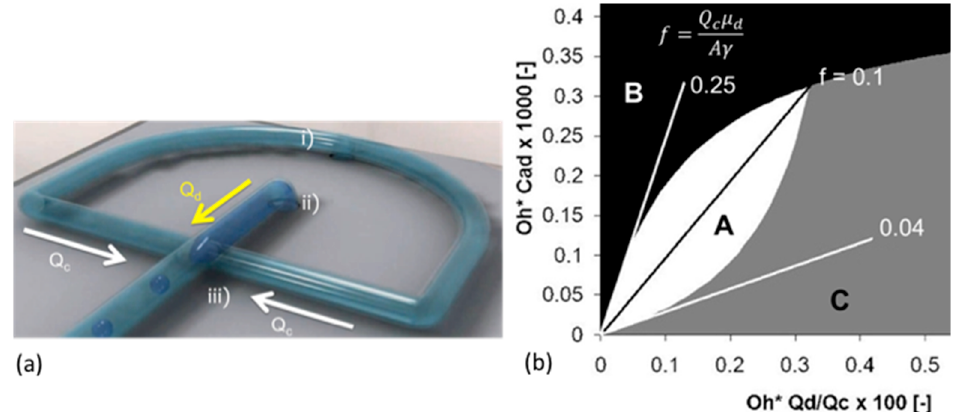
Figure 29. The microfluidic system and flow parameters that determine effective droplet formation. ( a ) Schematic 3D picture of droplet formation showing the arrangement of the two inlet tubes: (i) continuous phase inlet that then splits into two tubes; (ii) dispersed phase inlet; (iii) mixing head. (bottom) High-speed microscope image of the single-channel production window. ( b ) Flow map, depicting all combinations of liquid properties, microchannel size and flow rates. Combinations in the white area (region A) yield the desired process, i.e., spherical particles; combinations in the black area (region B) lead to instabilities and non-uniform droplets; and, in the grey area (region C), to droplets larger than the exit channel. From Kinoshita et al. [7] .